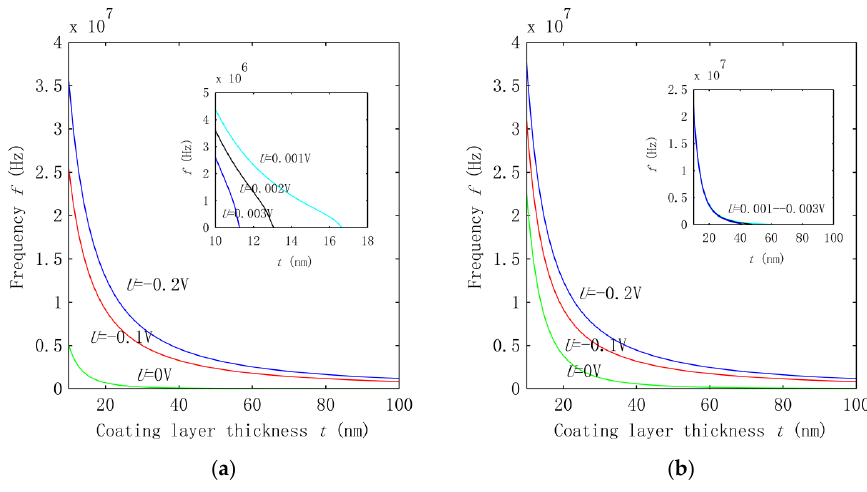
Figure 2. Frequencies of piezoelectric HNWs with interphase vdW interaction where the voltage applied is in the range of (− 0.2 V, 0.003 V), and the inner SWCNT has a radius ( a ) R = 0.68 nm and ( b ) R = 2.51 nm. The insets show the results for U = 0.001, 0.002 and 0.003 V.